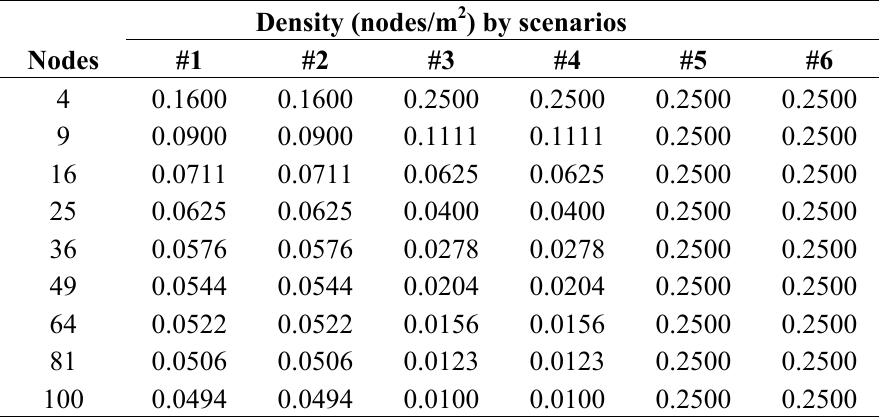
Table 3. Network density in the simulation scenarios.